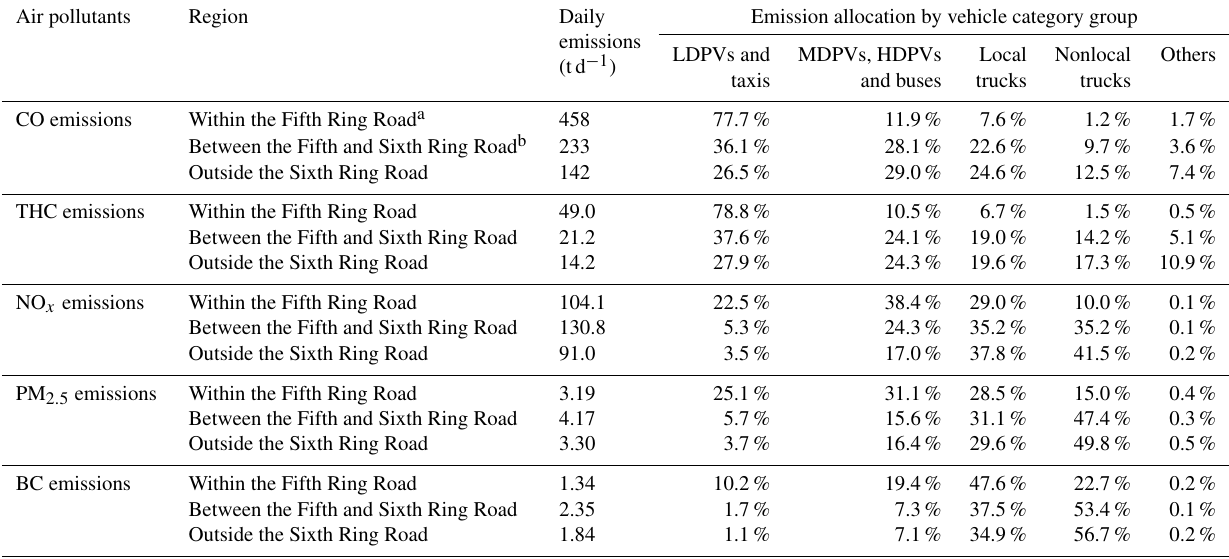
Table 1. Daily emission allocation by vehicle category and region under the weekday traffic scenario ( S1